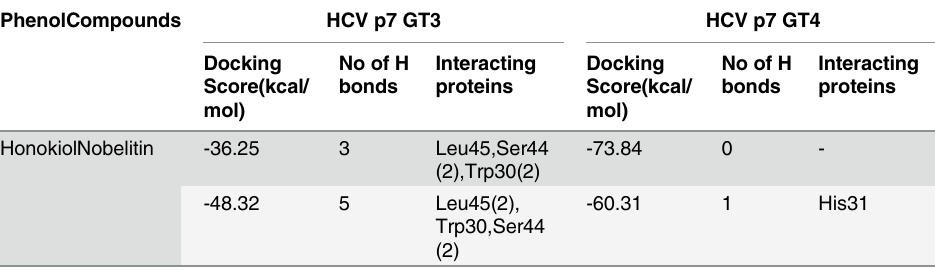
Table 9. Phenol compounds and their interactions with modeled p7 proteins from both genotypes as obtained from molecular docking